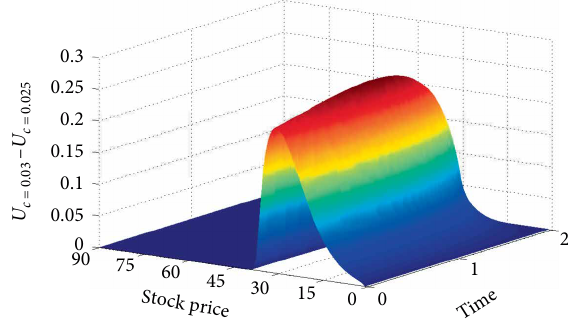
with 𝑟 = 0.05, 𝛾 = 0.06, 𝐺 = 1.2, .